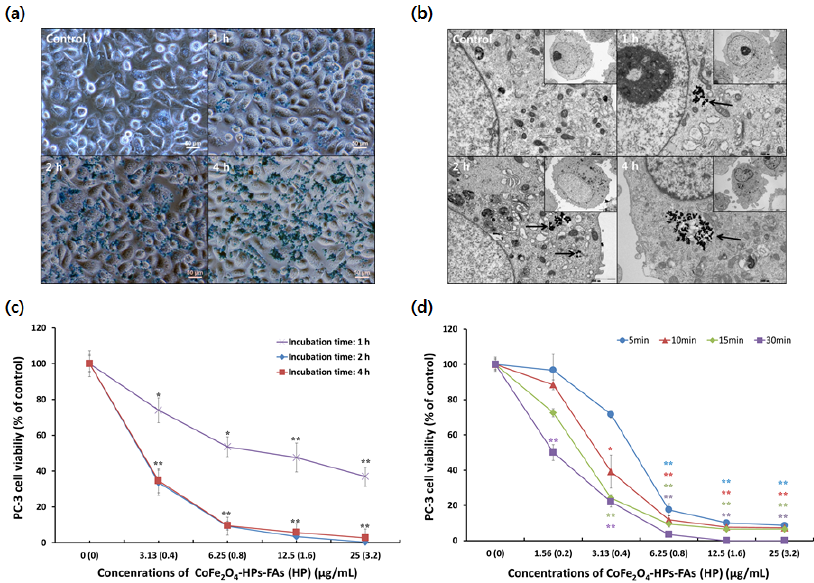
Figure 5. Cellular uptake, intracellular localization, and photodynamic anticancer activities of CoFe 2 O 4 -HPs-FAs in prostate cancer cells (PC-3 cells). ( a ) Microscopic and ( b ) transmission electron microscopic images of CoFe 2 O 4 -HPs-FAs in PC-3 cells to evaluate their cellular uptake and intracellular localization. PC-3 cells treated with 6.25 (0.8) µ g/mL CoFe 2 O 4 -HPs-FAs (HPs) were incubated for 1, 2, and 4 h in the dark. The TEM images are magnified from a whole cell image (inset). Black arrows indicate the CoFe 2 O 4 -HPs-FAs. The scale bars represent 50 µ m and 2 µ m; ( c ) Photodynamic anticancer activity of CoFe 2 O 4 -HPs-FAs according to the incubation time of CoFe 2 O 4 -HPs-FAs with prostate cancer cells (PC-3 cells); ( d ) Photodynamic anticancer activity of CoFe 2 O 4 -HPs-FAs according to the exposure dose of light emitting diode (LED) light to PC-3 cells. Data are expressed as the mean ± standard deviation ( n = 6) and were analyzed by Student’s t -tests. Statistical significance was defined as p < 0.05 (* p < 0.05, ** p < 0.005 vs. control at the same